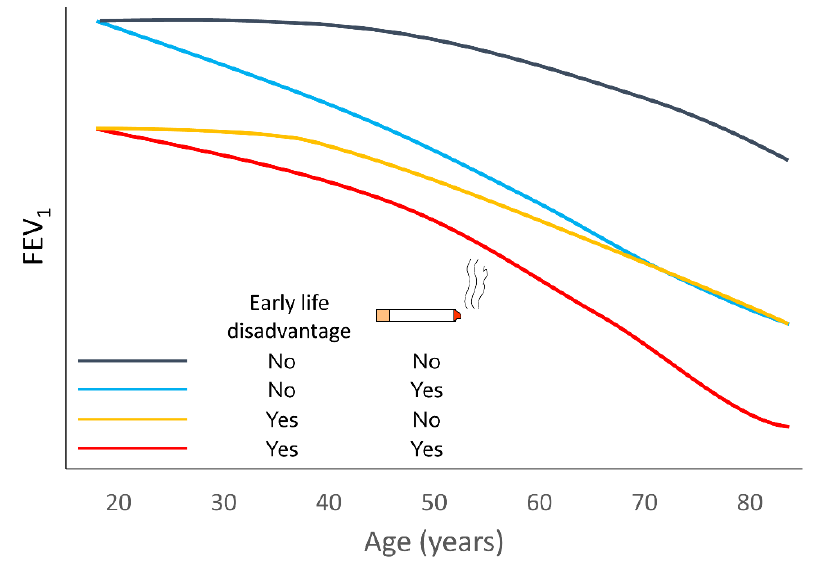
Figure 1. Lifelong lung function trajectories according to presence of early life disadvantages and tobacco exposures.